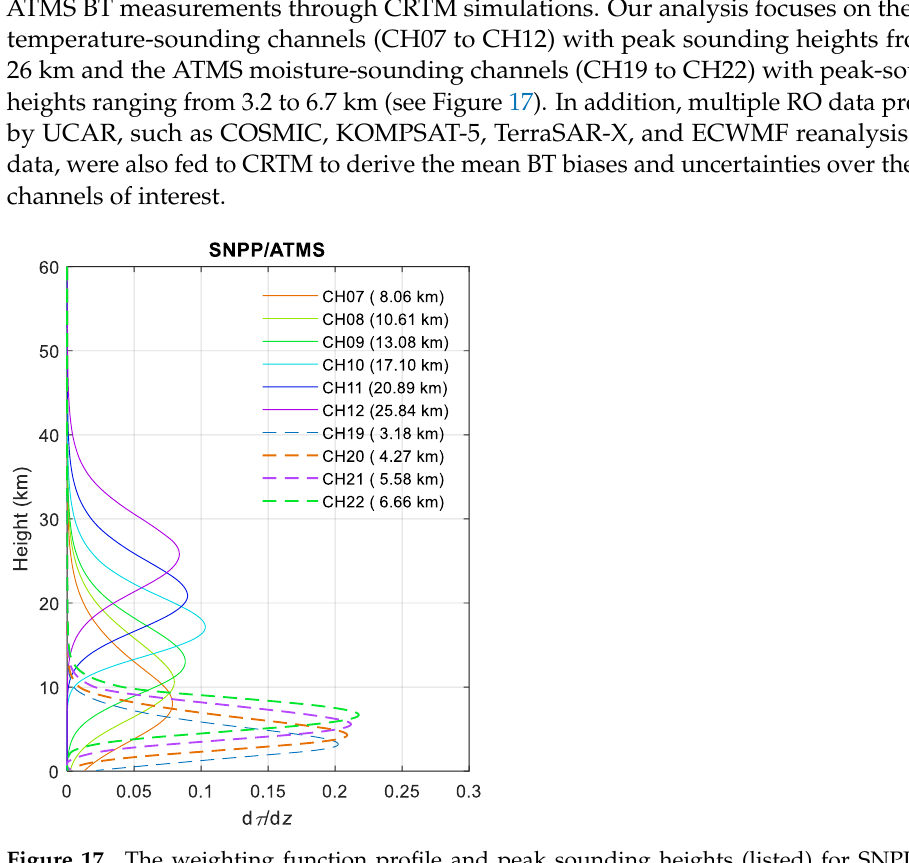
Figure 17. The weighting function profile and peak sounding heights (listed) for SNPP ATMS chan- nels CH07 – CH12 and CH19 – 22. channels CH07–CH12 and